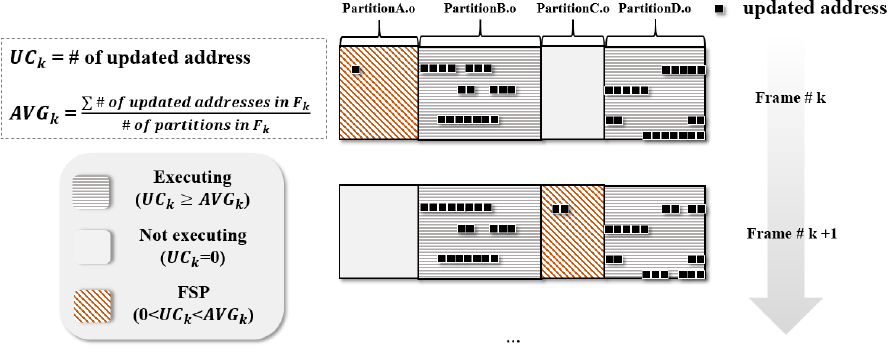
Figure 12. Three types of partition in the data section.